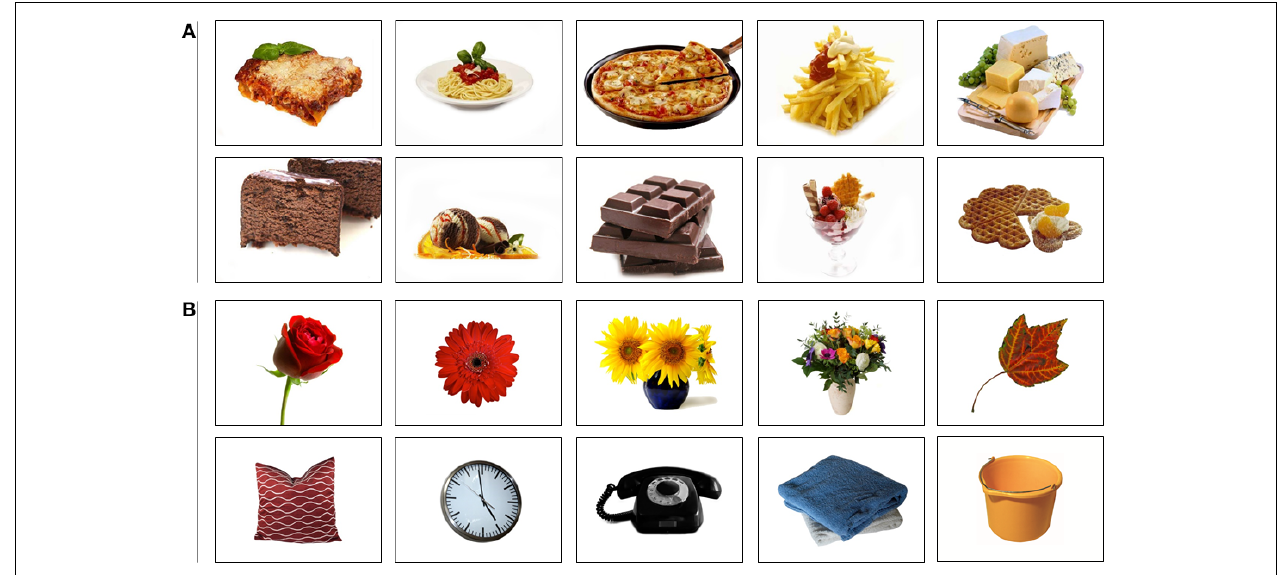
FIGURE 3 | Stimulus set of (A) food pictures and (B) neutral pictures in study 2.